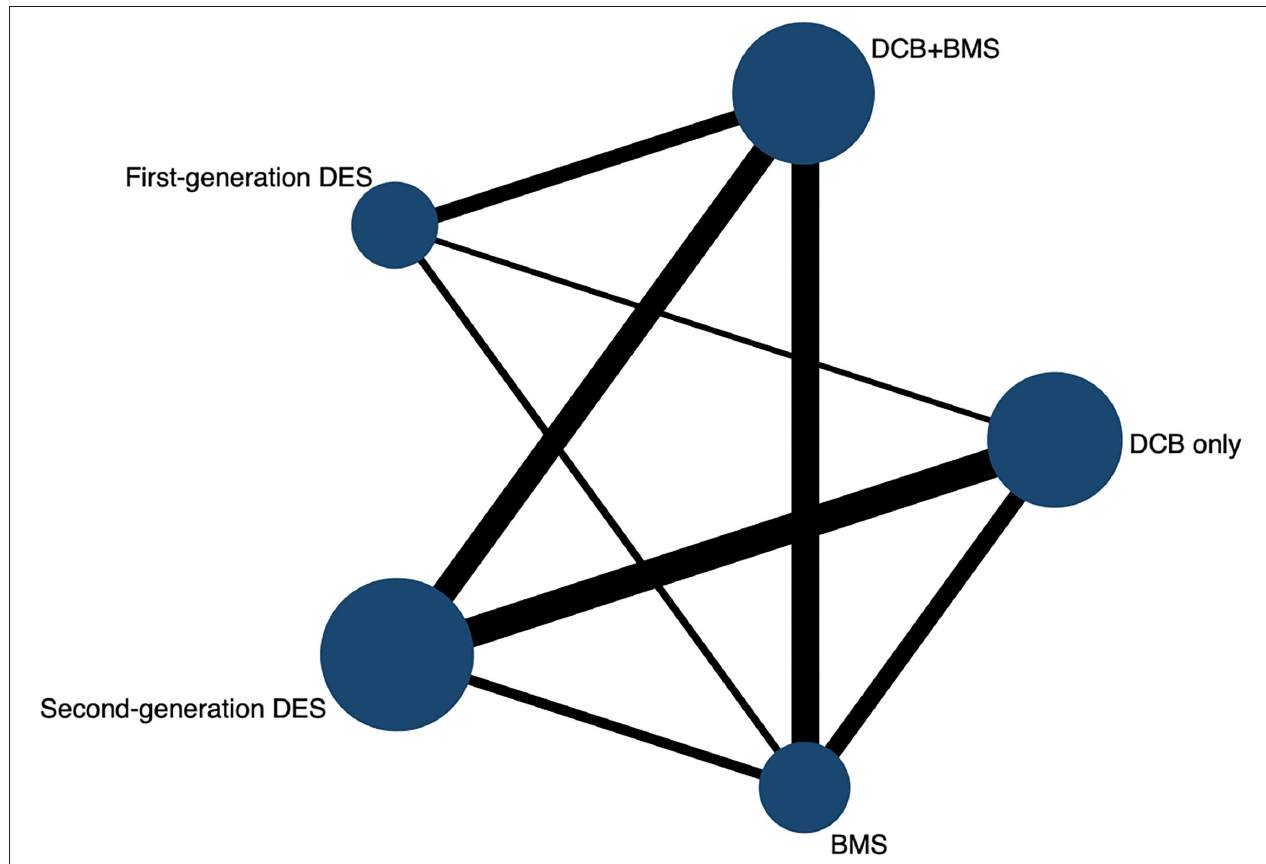
FIGURE 2 | Network evidence